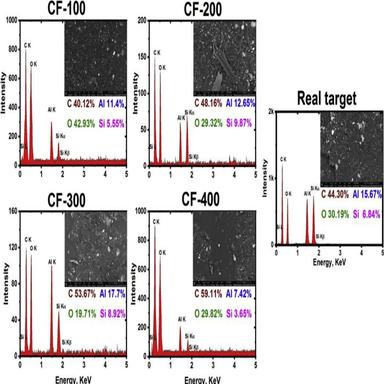
SEM images and the elemental analysis by EDX-a technique of the different density of carbon-fiber and the real target.